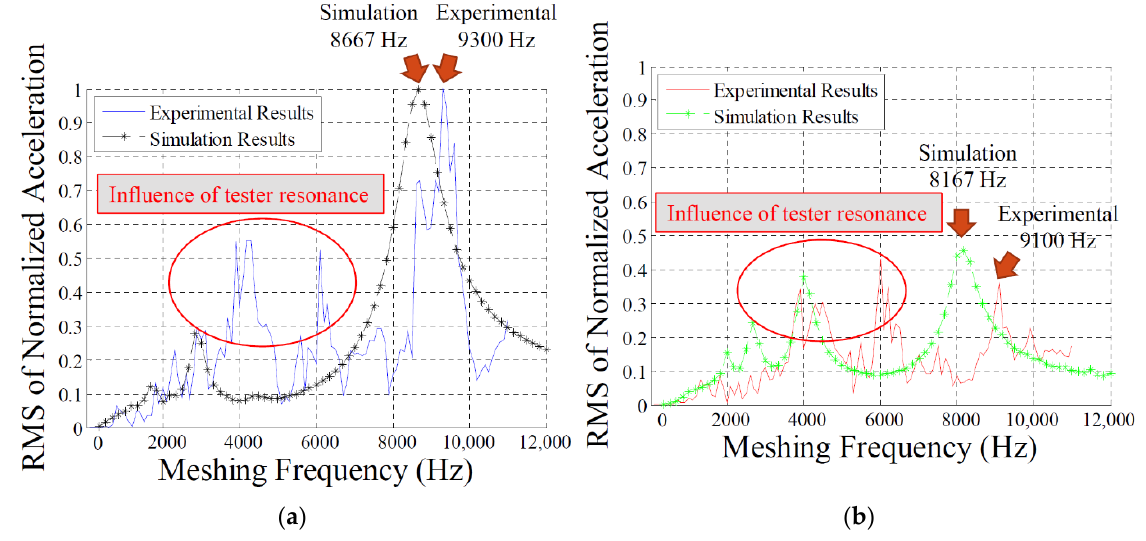
Figure 17. RMS of normalized acceleration. ( a ) Original design ( b ) optimum design.